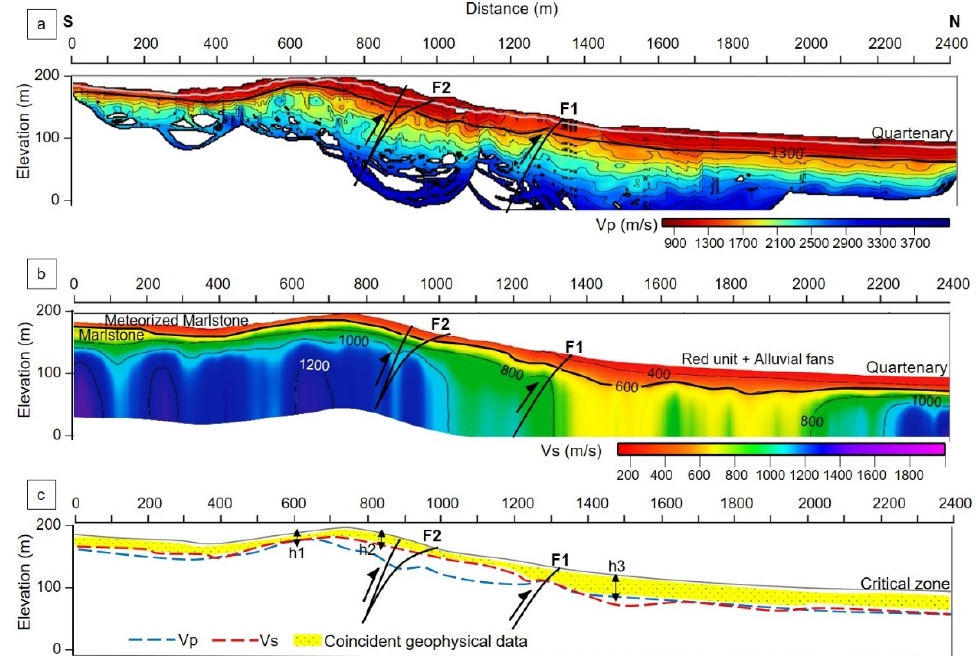
Figure 10. Geophysical imaging of Carrascoy site with the interpretation proposed and details. ( a ) The Vp model from seismic tomography, ( b ) the Vs model from MASW, and ( c ) a joint comparison of the interpreted CZ from both geophysical models. The low-velocity anomalies marked by F1 and F2 correspond to different thrust strands of the ACNF.